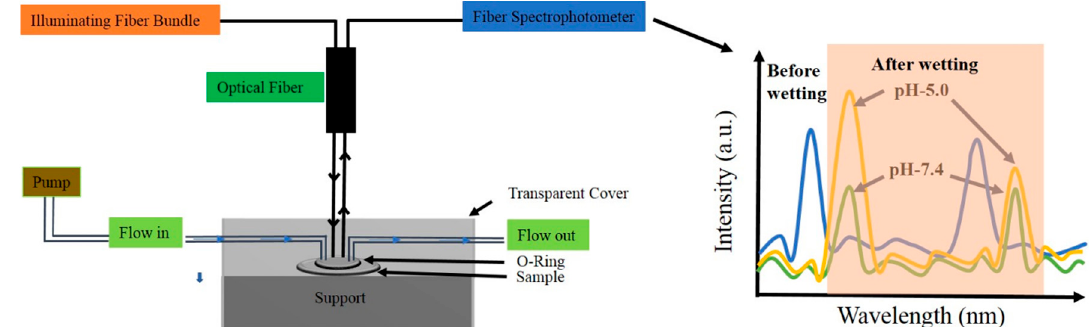
Figure 4. Schematic representation of the flow cell setup used for the real time monitoring of Rh6G dye release under different pH conditions. The intensity vs. wavelength graph on the right-hand side demonstrates the before- and after- wetting effect of the different pH solution on NAA-GIFs and the evolution of the spectra as the pH is changed from 7.4 to 5.0.2.6. Numerical Simulation.